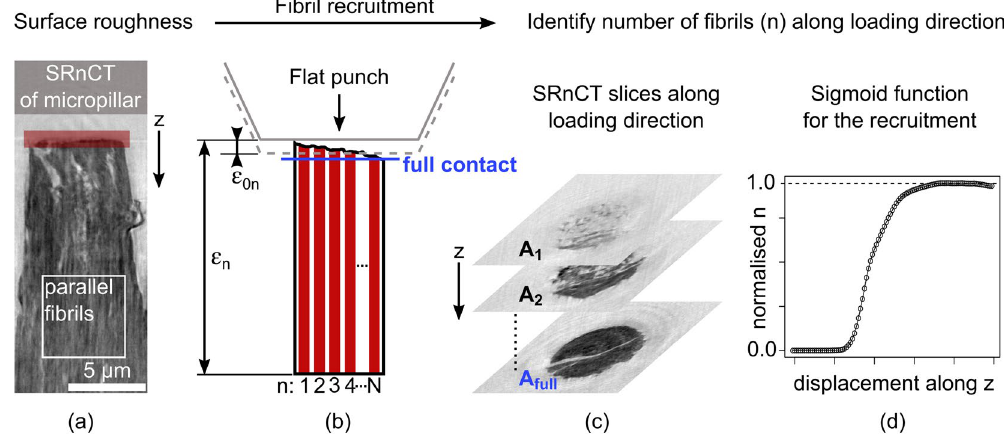
Figure 5. Quantification of the micropillar surface roughness to identify a non-linear function for the gradual fibril recruitment. ( a ) Reconstructed SRnCT image of a compressed micropillar with focus on the top part (red). Axial slicing and loading had the same direction denoted by z. ( b ) A diamond flat punch compresses a micropillar with N fibrils. The total strain ε n that is experienced by fibril n depends on its relative position to the flat punch. The corresponding fibril-specific strain offset value ε 0 n is then used in the ε n calculation. (c) The grey-value areas ( A 1 , A 2 ... A full ) related to the micropillar in the cross-sectional SRnCT slices were used to calculate area fractions relative to the point of full contact between flat punch and micropillar. ( d ) Based on the fibril volume fraction, a normalised number of fibrils along the loading direction was calculated and fitted with a non-linear function in R (V3.6.2) 73 .